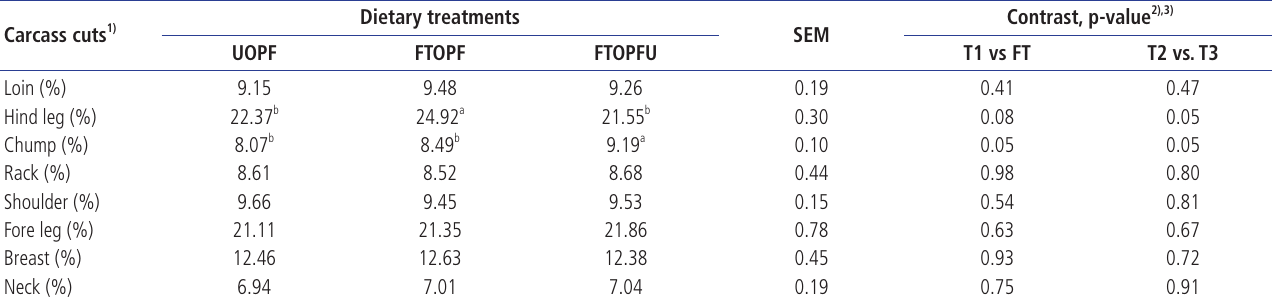
Table 4. Effects of diet on carcass composition of finishing goats Carcass cuts